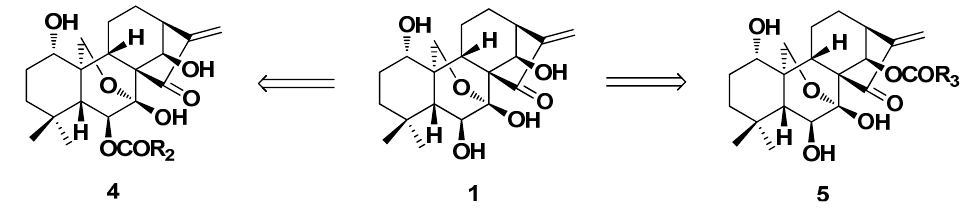
Figure 3. Selective acylated products of oridonin at 6- O ( 4 ) or 14- O ( 5 ).